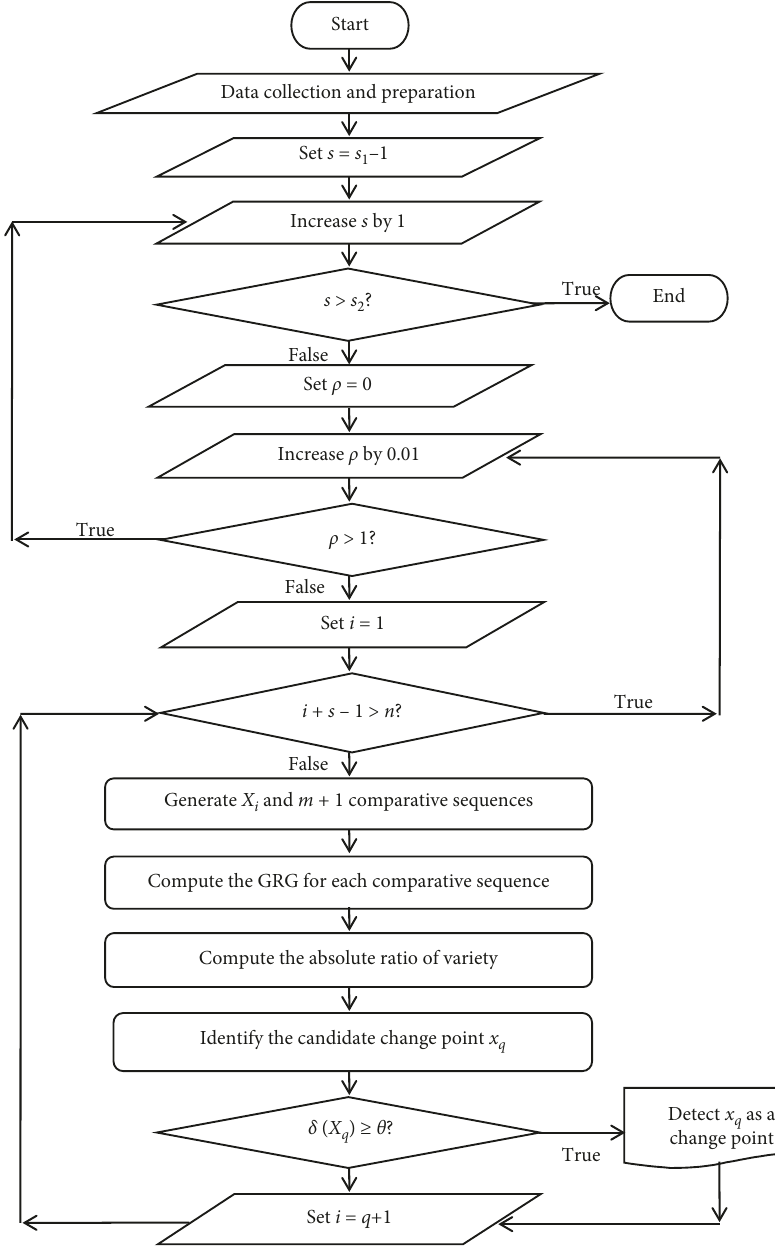
Figure 1: Flowchart of the proposed grey CPD